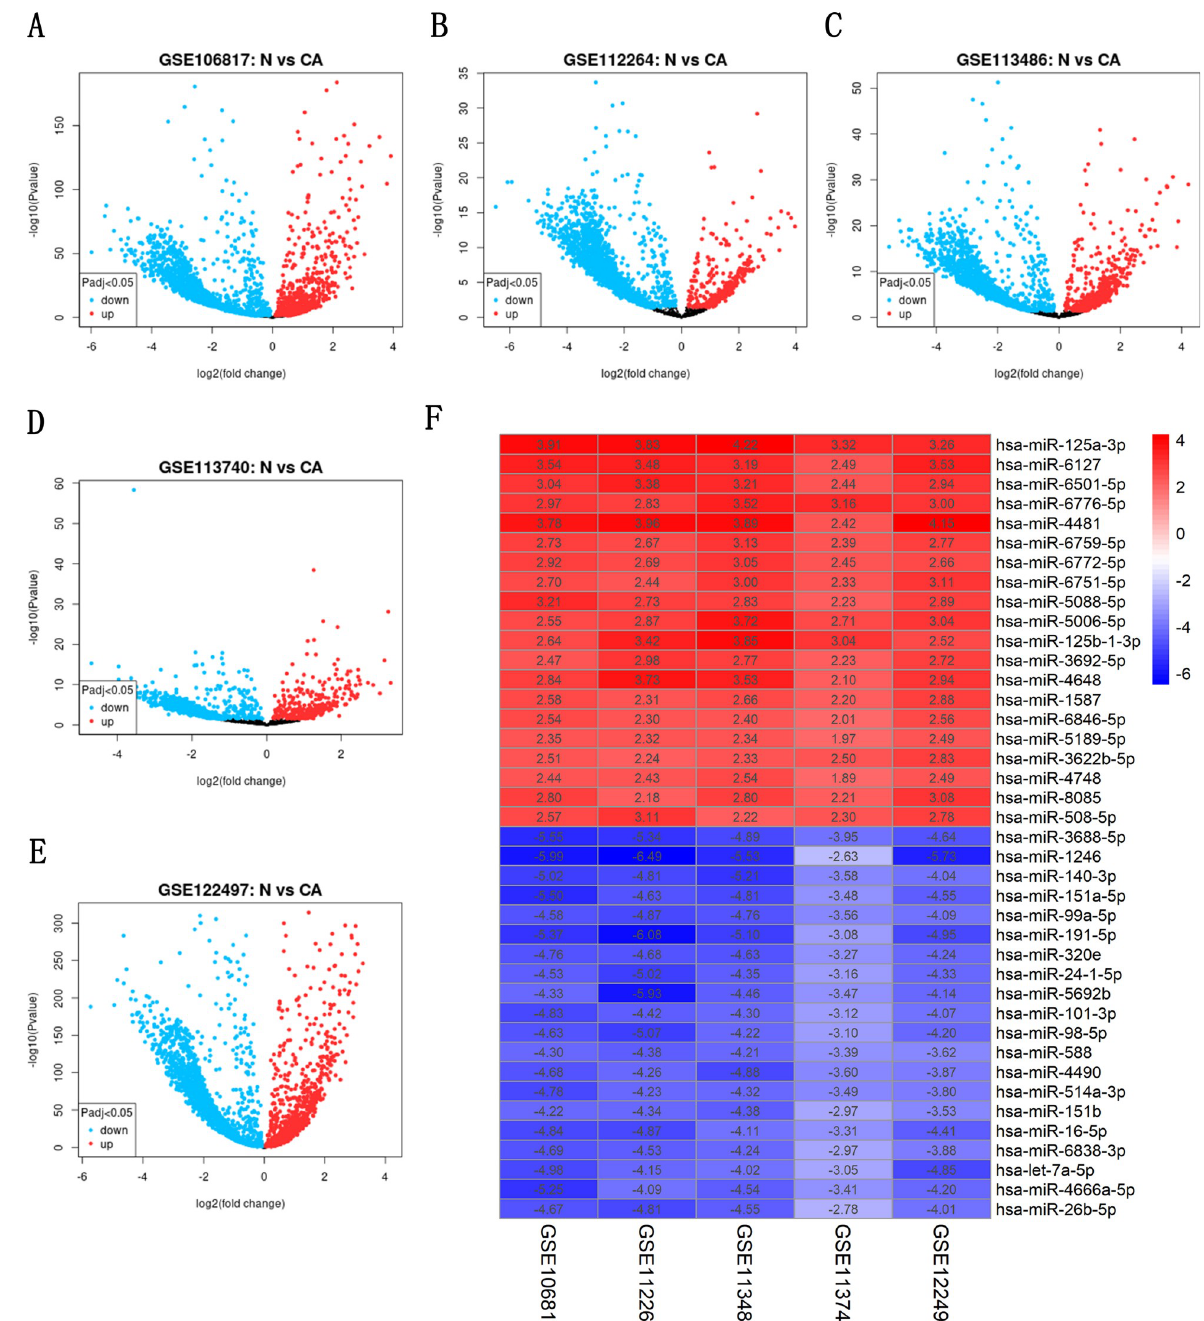
Fig 1. Volcano plots of differentially expressed genes in GSE113740, GSE112264, GSE122497, GSE113486, and GSE10681 and log2FC heatmap of each expression microarray. (A-E) show the volcano plots of differentially expressed genes in GSE10681, GSE112264, GSE113486, GSE113740, and GSE122497, respectively. The horizontal coordinates represent log2 (fold change), blue represents downregulated genes, and red represents upregulated genes. The vertical coordinate represents -log10 (p value). N is the normal control group; CA is the cancer group. (F) shows the log2FC heat map of GSE113740, GSE112264, GSE122497, GSE113486, and GSE10681. The numbers in the plot show the log2FC for each expression microarray, with red indicating upregulation, and blue indicating downregulation.